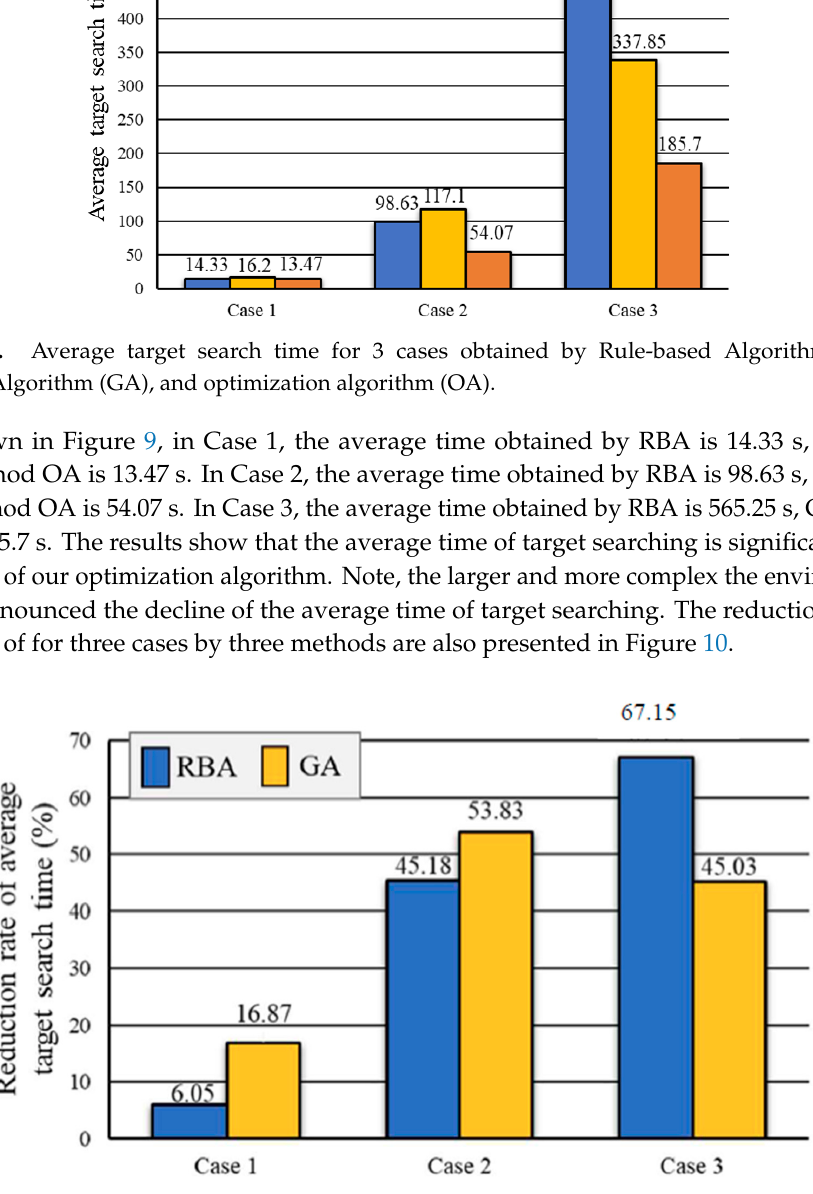
Figure 10. The reduction rate of average target search time by OA, RBA, and